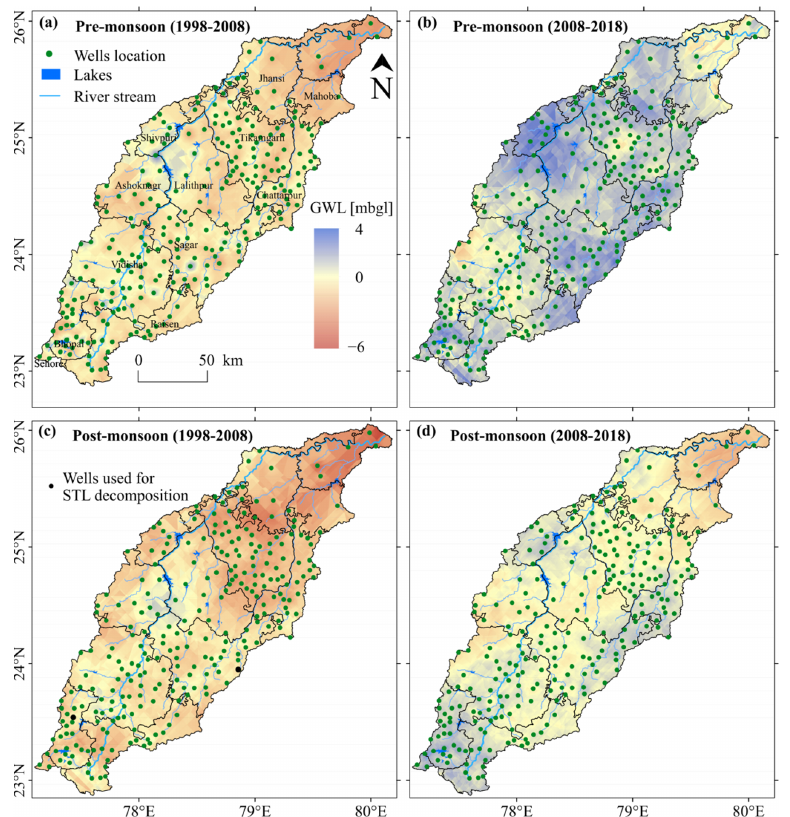
Figure 5. Spatial distribution of GWL change during the pre ‐ monsoon period for 1998–2008 and 2008–2018 ( a , b ). The GWL change post ‐ monsoon (bottom) periods (for 1998–2008 and 2008–2018) ( c , d ). The positive values (blue) indicate an increase, and the negative ones (red) show a decrease in GWL. The green dots show the wells used for interpolation of the GWL map for the respective periods. The solid black dots show wells used for the STL decomposition of GWL.